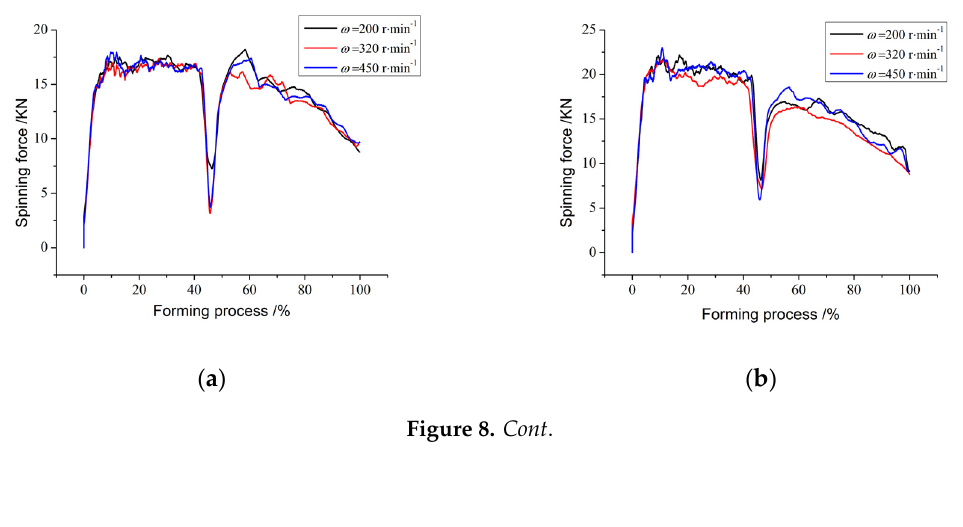
Table 3. The single factor variable test plan.